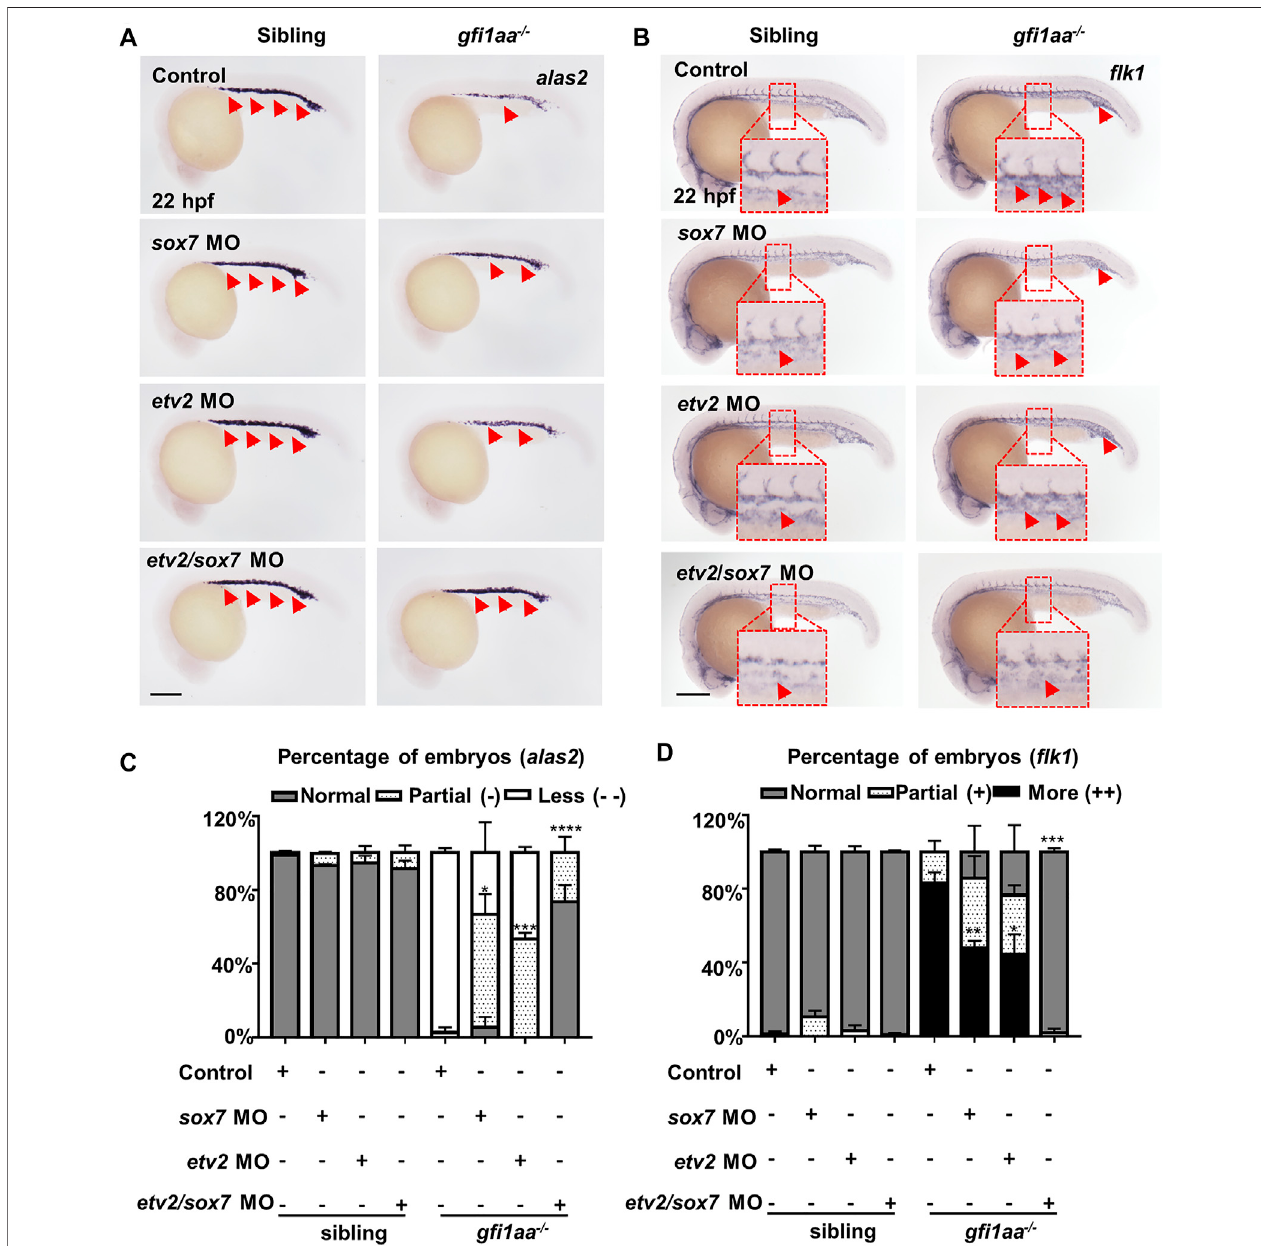
FIGURE4| sox7 and etv2 actcooperativelytorescuethehematopoieticdefectof g fi 1aa mutant (A, B) Expressionof alas2 (A) and fl k1 (B) insiblingsand g fi 1aa − / −